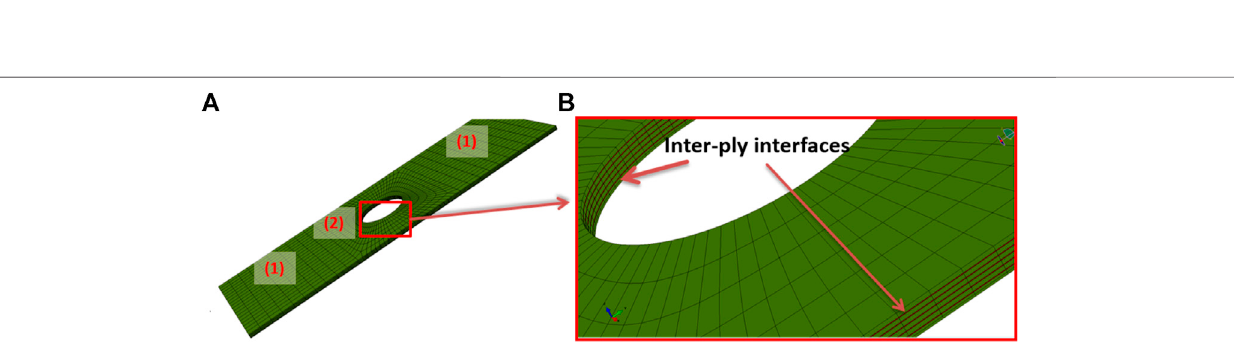
FIGURE 5 | Sample with an open hole: (A) a locally re fi ned mesh is used to deal with stress concentration; (B) inter-ply interfaces are modeled using the “ surface- based cohesive behavior model. ”